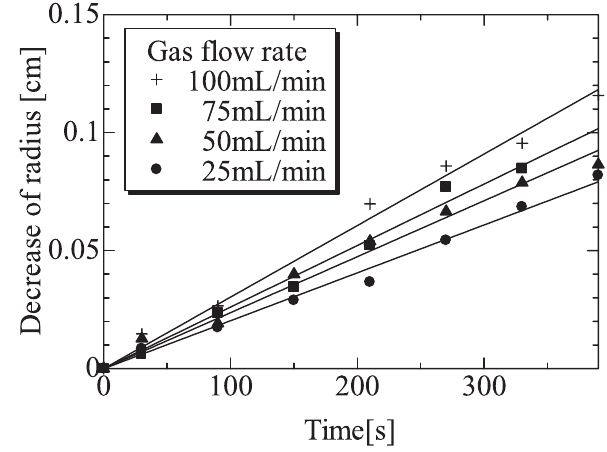
Fig. 14: Decrease of radius with time when 3.5 g of sintered lime (s-Lime) dissolved into 100 g of FeO-CaO-SiO